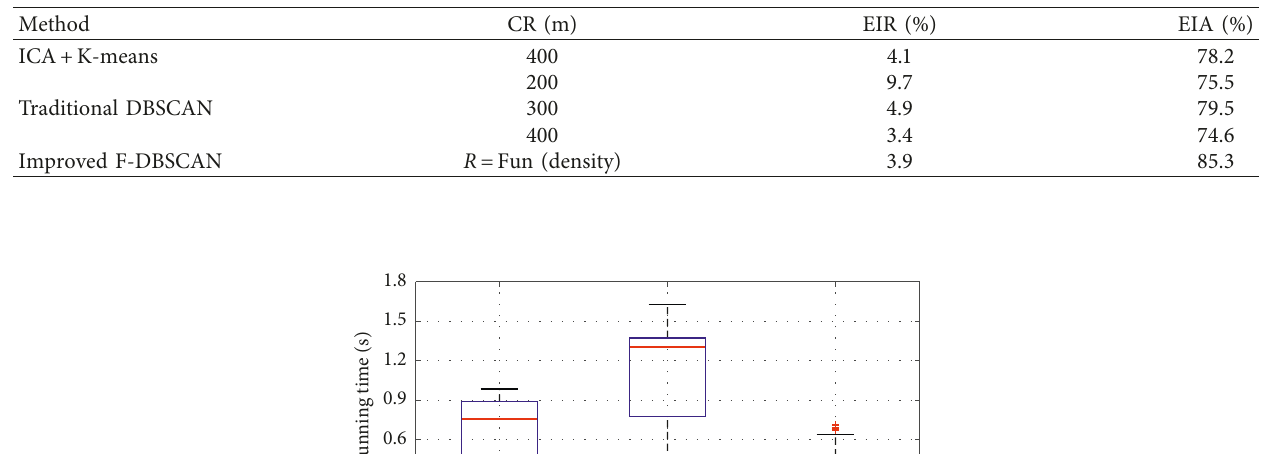
Table 2: Comparison of identification accuracy among different methods.